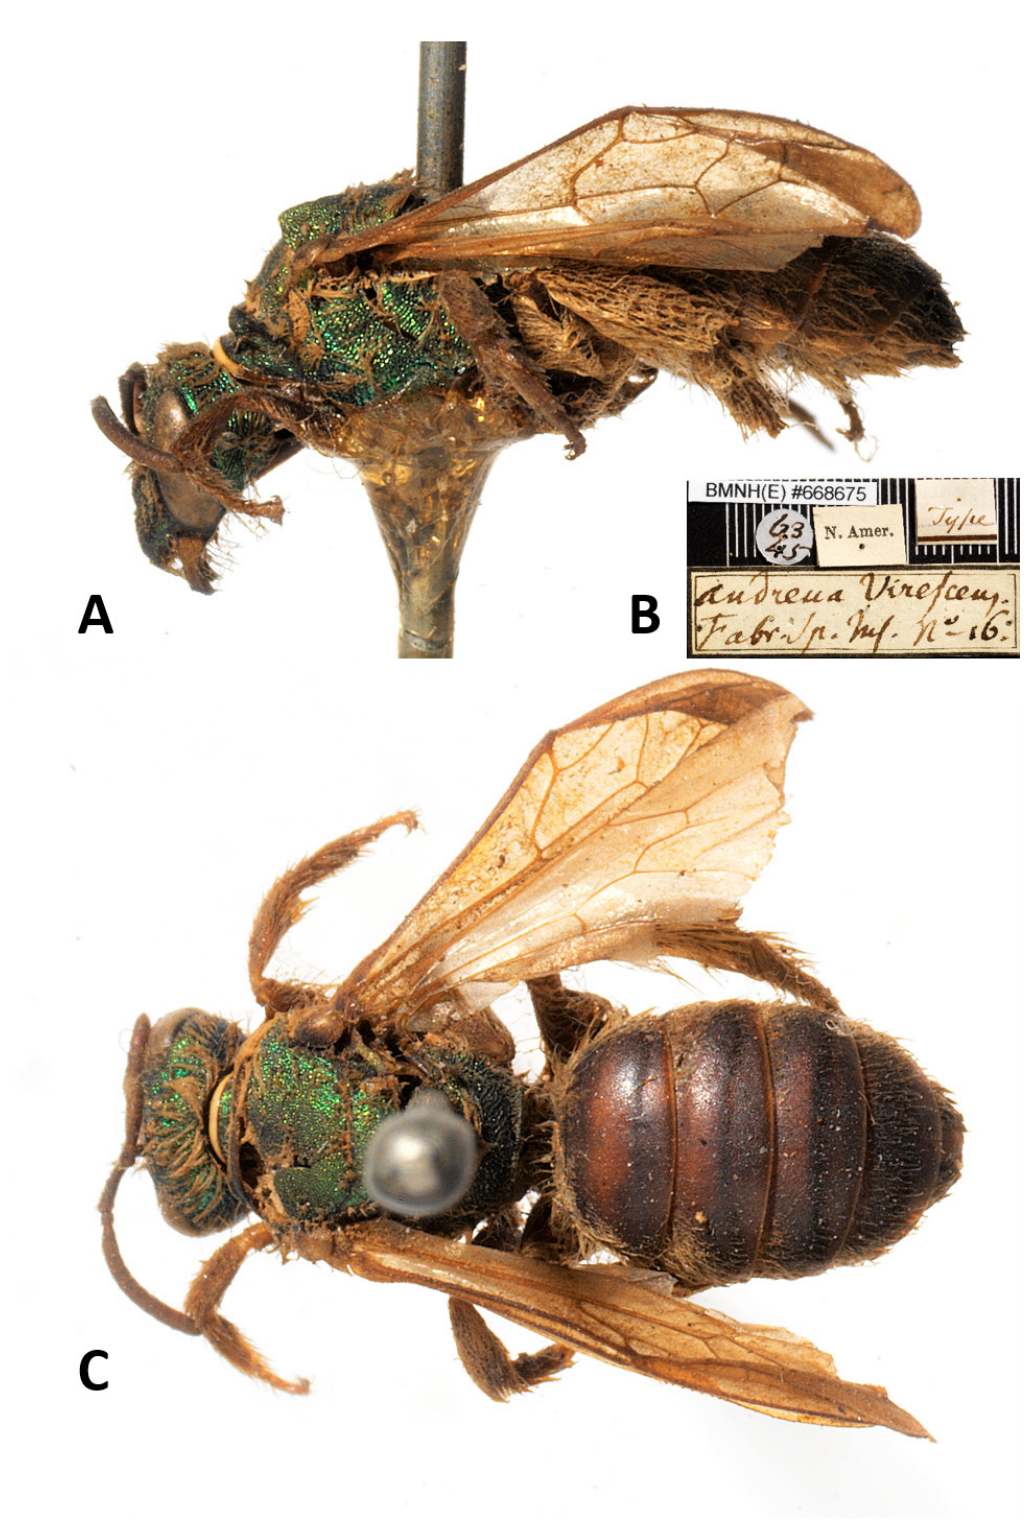
Fig. 1. Andrena virescens Fabricius, 1775. Holotype, ♀ (BMNH(E) 668675). A . Lateral view. B . Associated labels. C . Dorsal view. Photo credit: Natural History Museum, London (2020). Data Portal Query on “Specimens” https://doi.org/10.5519/qd.7pgn1j4u. Subset of “Collection specimens” (dataset) https://doi.org/10.5519/0002965. Layout modified from